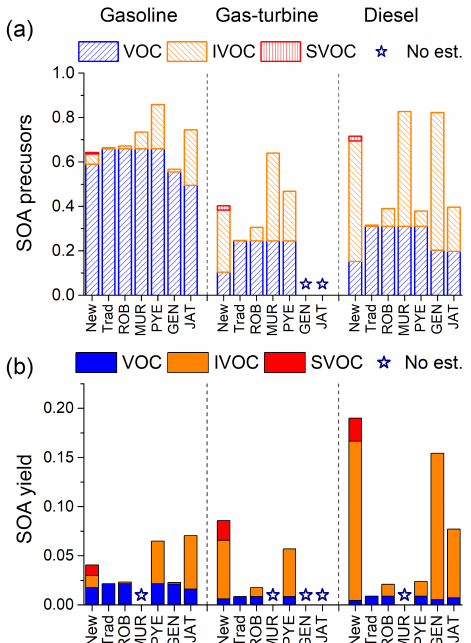
Figure 7. Comparison of (a) mass fraction of SOA precursors in to- tal NMOG emissions and (b) calculated total SOA yields of NMOG emissions from mobile sources based on the different estimation ap- proaches listed in Table 1. Star denotes no estimate